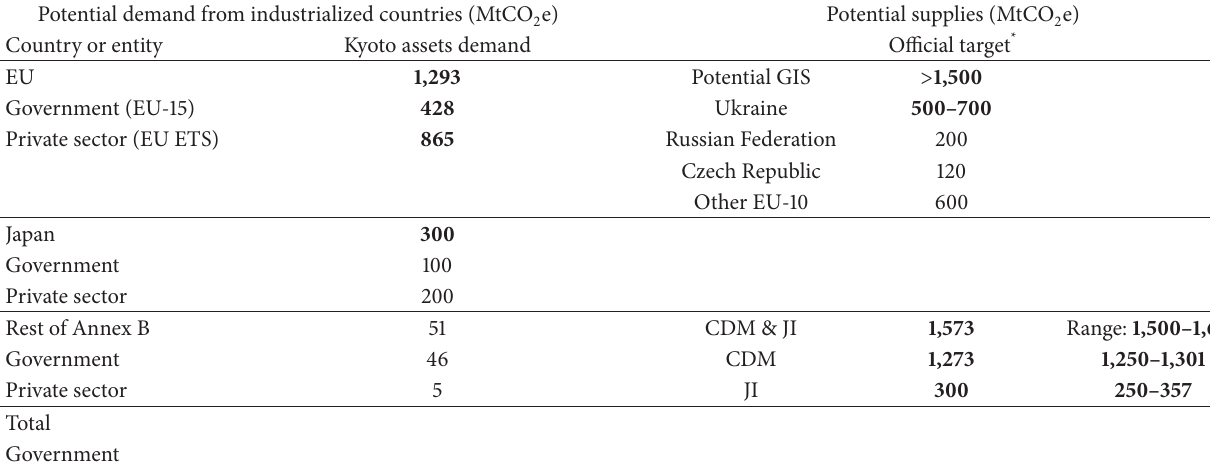
Table 1: Demand forecast of national carbon offset in non-Annex I countries during the period 2008–2012 [13].